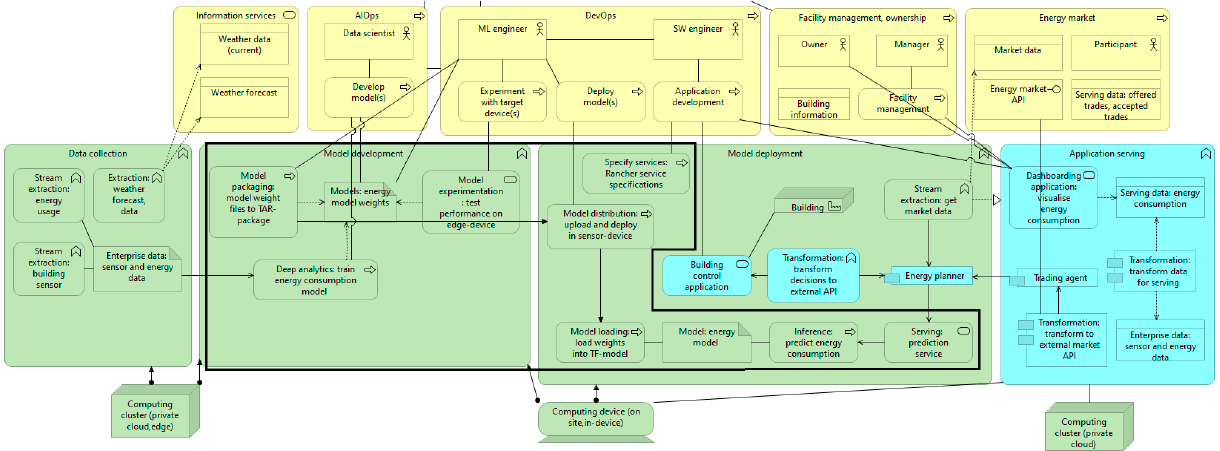
Figure 4. Model development of deployment view of the architecture. Elements are divided into technological layer (green), application layer (blue), and business layer (yellow). The implemented elements have been marked off with a black line.